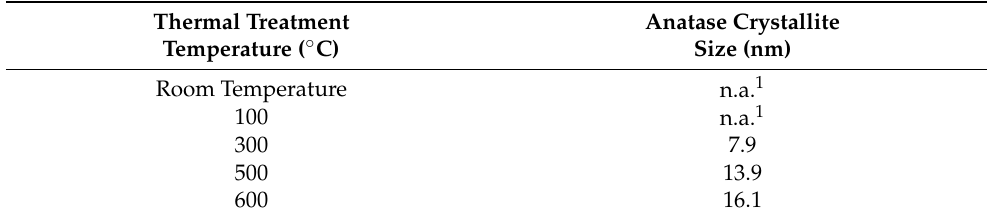
Table 1. Anatase crystallite sizes at different annealing temperatures. At room temperature and 100 ◦ C, no crystallite size was calculated due to poor peak definition.